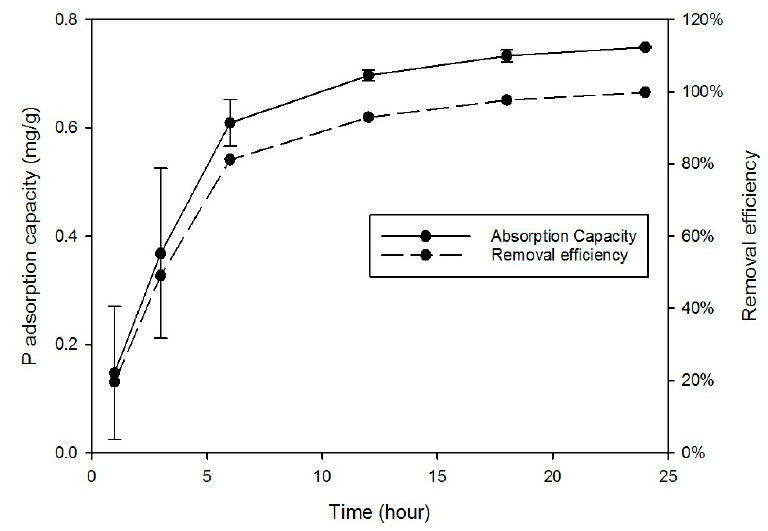
Figure 5. Kinetic studies of P adsorption; Initial P concentration 15 mg/L; agitator 180-rpm; pH-5;